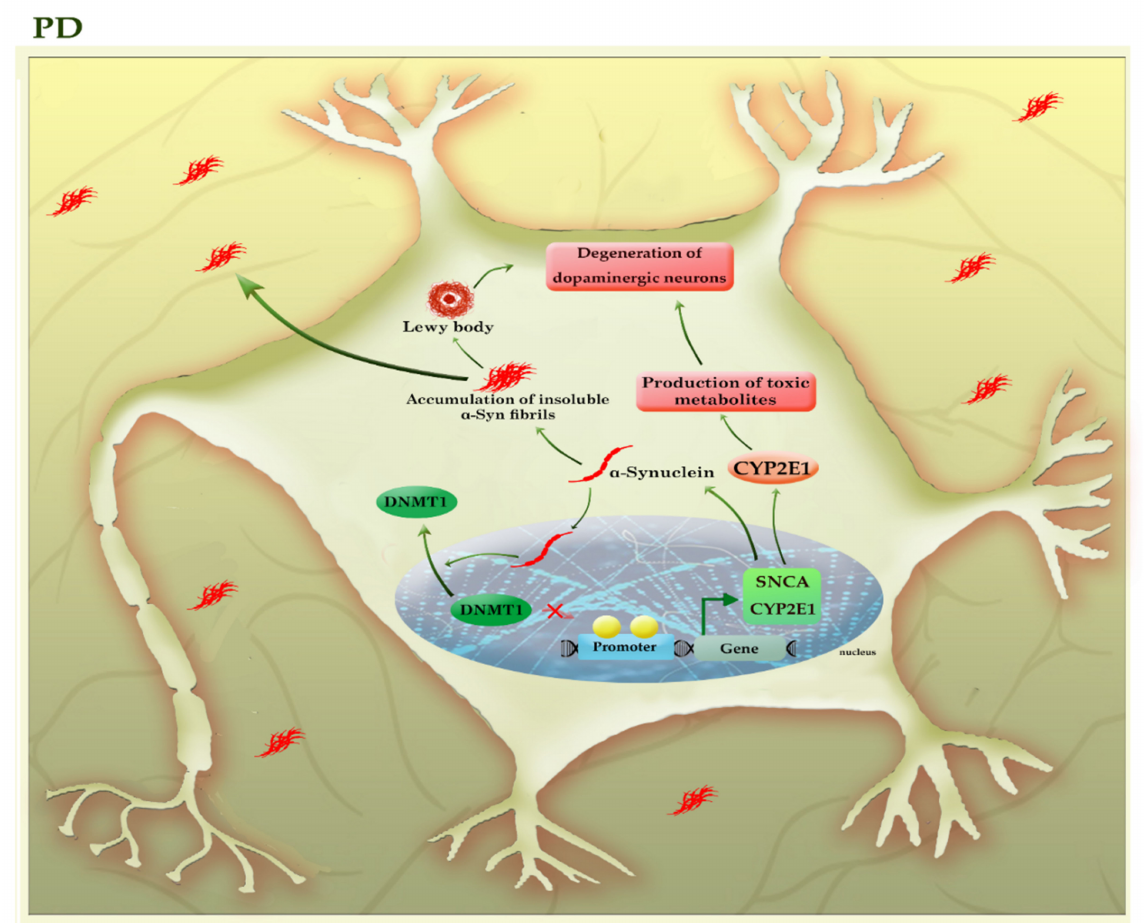
Figure 5. A schematic representation of the selected mechanisms in the pathogenesis of PD. The higher levels of α -synuclein (SNCA) can accumulate to form oligomers, insoluble fibrils, and ultimately “Lewy bodies”, triggering apoptosis within the neural cells. α -synuclein can relocate DNMT1 from the nucleus into the cytoplasm of neural cells and depletes the nuclear reservoir of this DNMT, thereby leading to the hypomethylation and associated with the upregulation of many PD-related genes, including SNCA and CYP2E1 . The increased activity of the CYP2E1 gene may contribute to the degeneration of dopaminergic neurons by the formation of toxic metabolites. The light green colors highlighted hypomethylated genes. CYP2E1 : cytochrome P450 2E1; SNCA ( α -Syn): synuclein